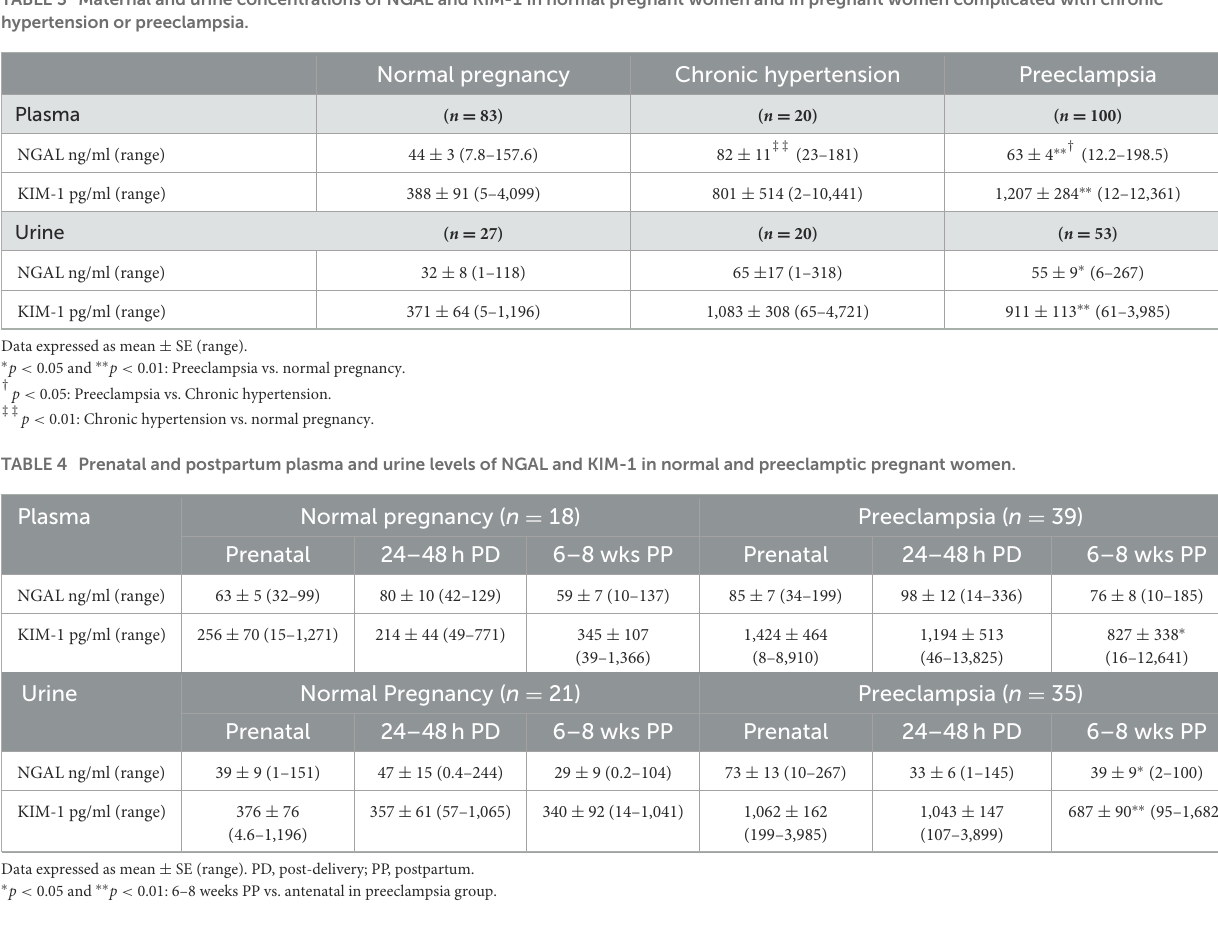
NGAL and KIM-1 expression was detected in proximal tubule epithelial cells in all preeclamptic cases (Figures 2A,